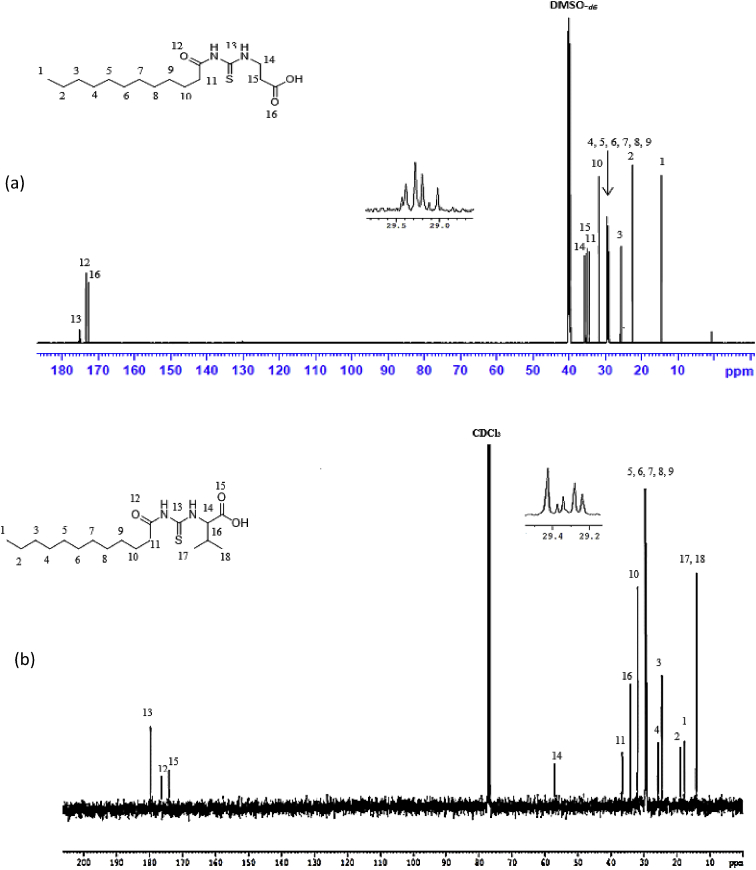
13C NMR spectra of (a) R1, (b) R2, (c) R3, (d) R4.